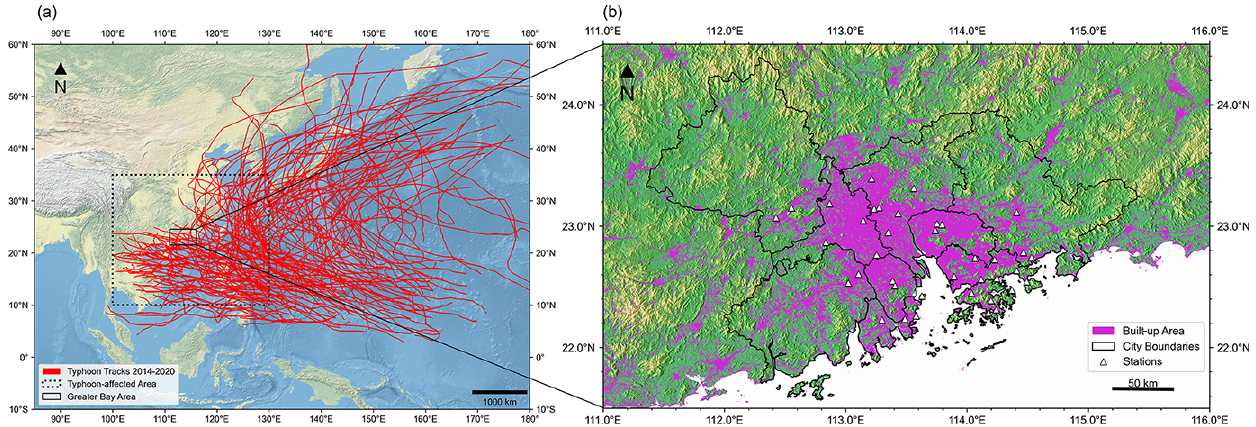
Figure 1. Overview of the data used in this study: (a) tracks of the studied typhoons (only those typhoons within the dotted box area are introduced into the model); (b) locations of the 39 observation stations.